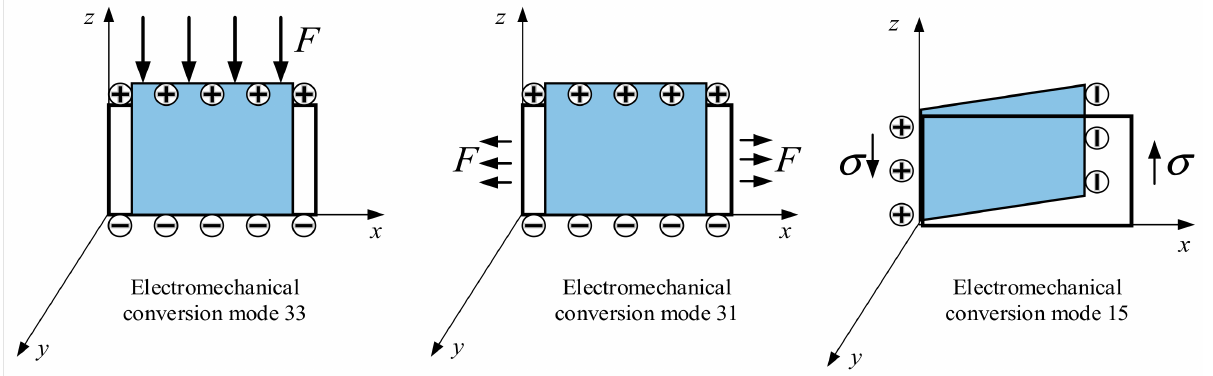
Figure 4. Electromechanical conversion type of piezoelectric